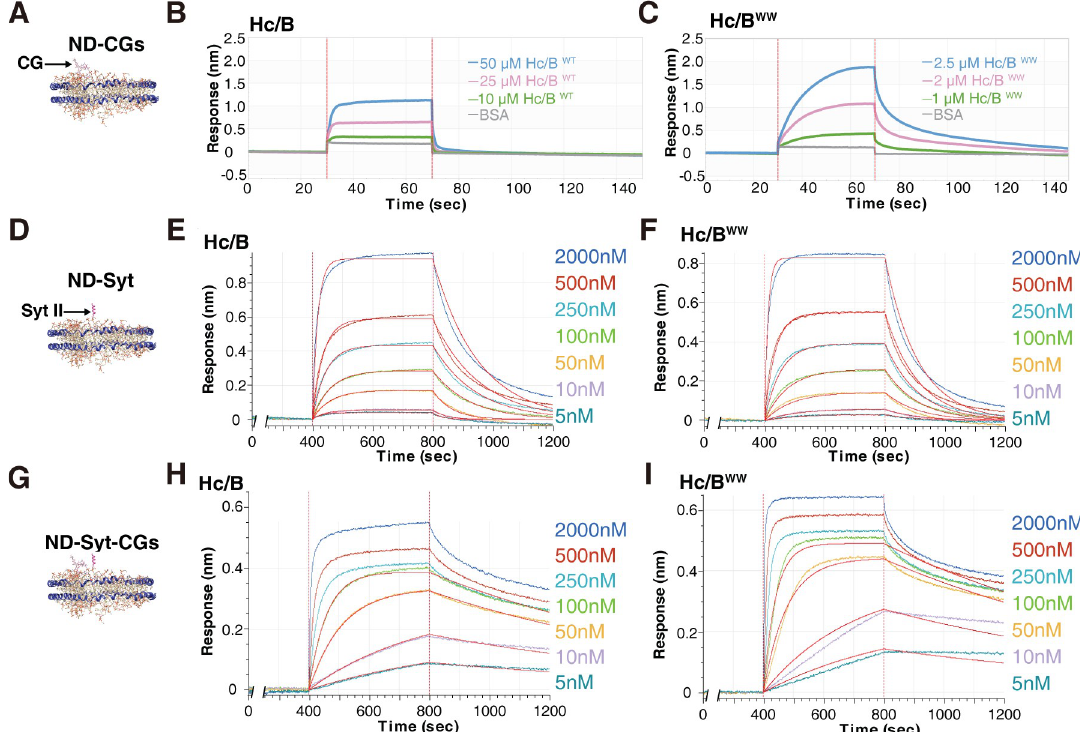
Fig 4. Lipid-binding capability synergizes with BoNT/B-CGs interactions. (A–C) Binding of WT H C /B and H C /B WW to ND-CGs was analyzed by BLI assays. Binding kinetics were analyzed and listed in S1 Table. (D–F) Binding of WT H C /B and H C /B WW to ND-Syt was analyzed by BLI assays using the Octet RED 384 system at the indicated concentrations. Binding curves were fitted using a 1:1 binding model, and fitted lines are shown in red. Binding kinetics were analyzed and listed in S1 Table. (G–I) Binding of WT H C /B and H C /B WW to ND-Syt-CGs, which contains both Syt II and CGs, was analyzed by BLI assays using the Octet RED 384 system at the indicated concentrations. Interactions involve at least three heterogeneous components, and it is not possible to draw a precise binding K D for comparison. Binding curves were fitted using a 1:1 binding model, and fitted lines are shown in red. Estimated K D using a single–binding site model is included in S1 Table. BLI, biolayer interferometry; BoNT, botulinum neurotoxin; BSA, bovine serum albumin; CG, complex ganglioside; H C , C-terminal receptor-binding domain; K D , equilibrium dissociation constant; ND, nanodisc; Syt, synaptotagmin; WT, wild-type.